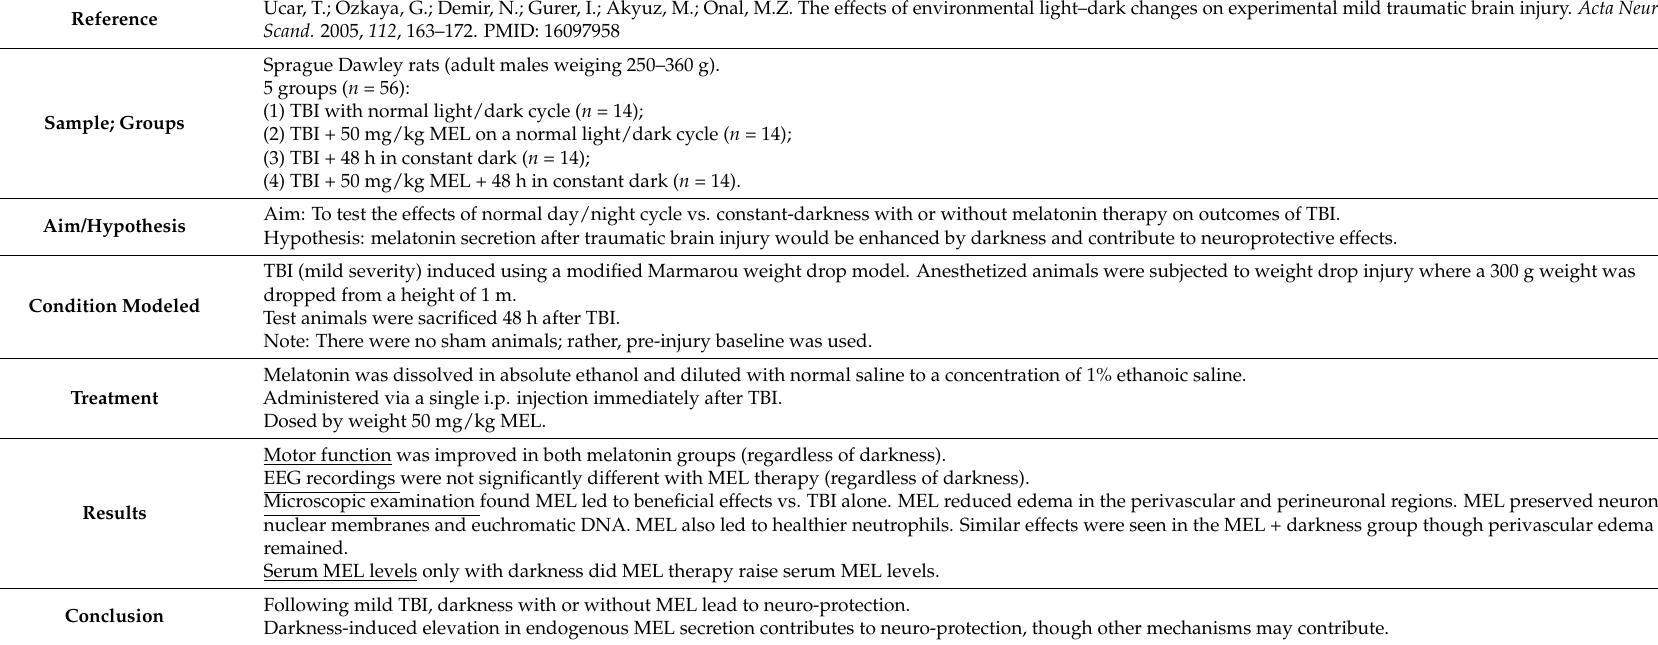
Table A7. Ucar et al. (2005) Study